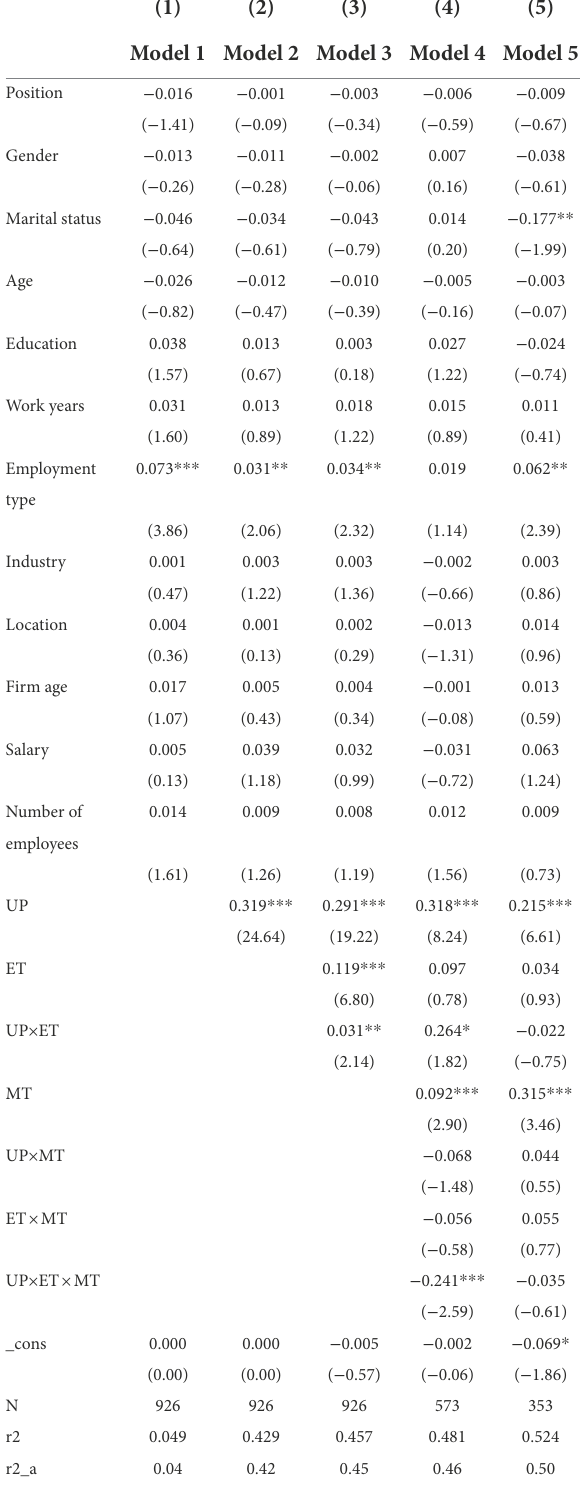
TABLE 3 Results of regression